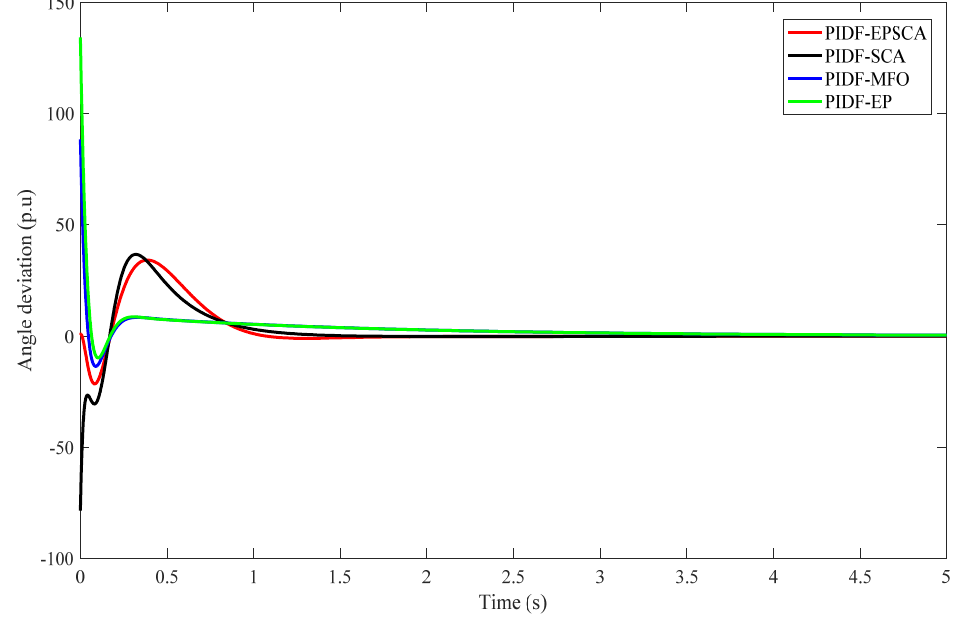
Figure 21. Angle deviation response of the TCSC-PIDF controller using PIDF-EPSCA, PIDF-SCA, PIDF-MFO, and PIDF-EP techniques for Scenario A-3.